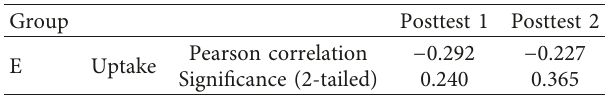
Table 12: Correlations between measures of uptake and posttests for the E group.